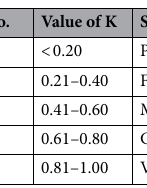
Table 2. Kappa coefficient